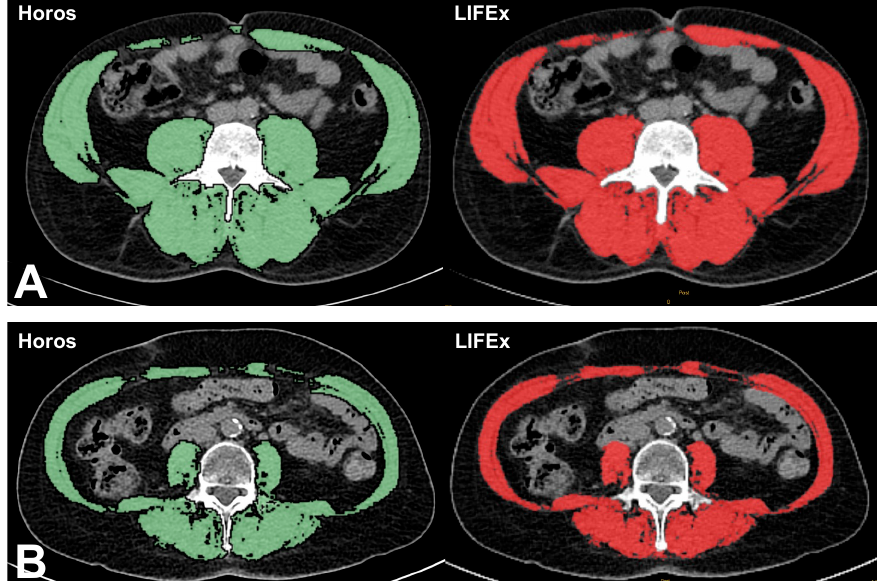
Figure 7. Comparison between muscle areas of two patients ( A , B ), achieved through Horos (green) and LIFEx (red) software. Patient A is a 70-year-old woman with pulmonary carcinoma. Muscle area was 99 cm 2 with Horos and 98 cm 2 with LIFEx. Patient B is a 56-year-old man with prostatic tumor. Muscle area was 206 cm 2 with Horos and 206 cm 2 with LIFEx.